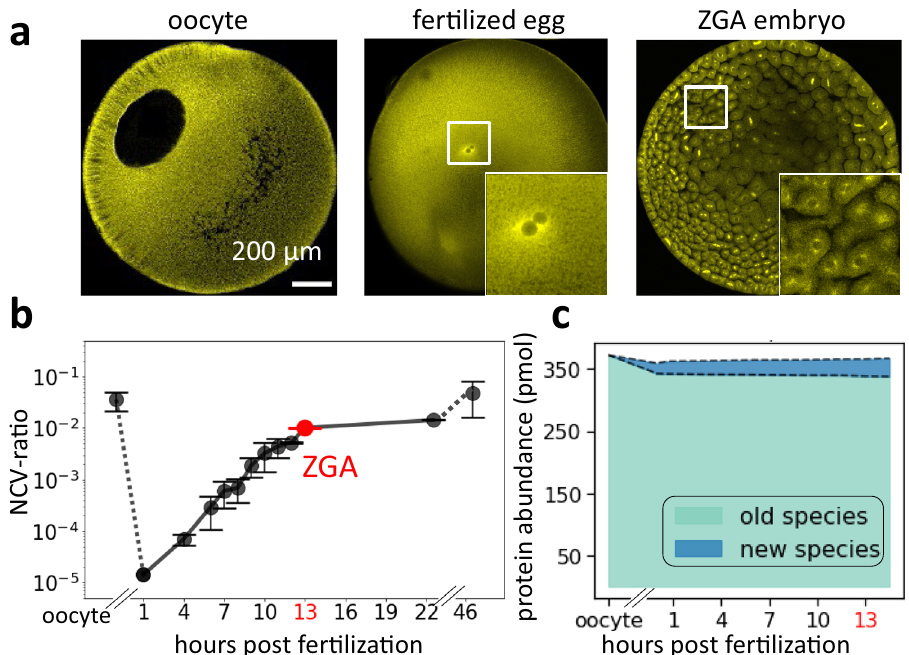
Fig. 1 | In early embryonic development, nuclear morphology changes drasti- cally while nuclear proteome composition changes little. a Immuno fl uorescence images (anti-tubulin) of early frog development show drastic changes in nuclear morphology. The large oocyte (~1.2mm diameter) con- tains a proportionally large nucleus (~400 μ m). After fertilization, the nucleus is only ~30 μ m in diameter. Around zygotic genome activation (ZGA), the embryo contains ~4000 cells with ~18 μ m diameter nuclei. The represented images were independently repeated multiple times and observed with similar results. b The nucleocytoplasmic volume ratio (NCV-ratio) in early frog development, quanti fi ed basedon micrographs.The NCV-ratio drops~10,000-fold from oocyte to fertilized